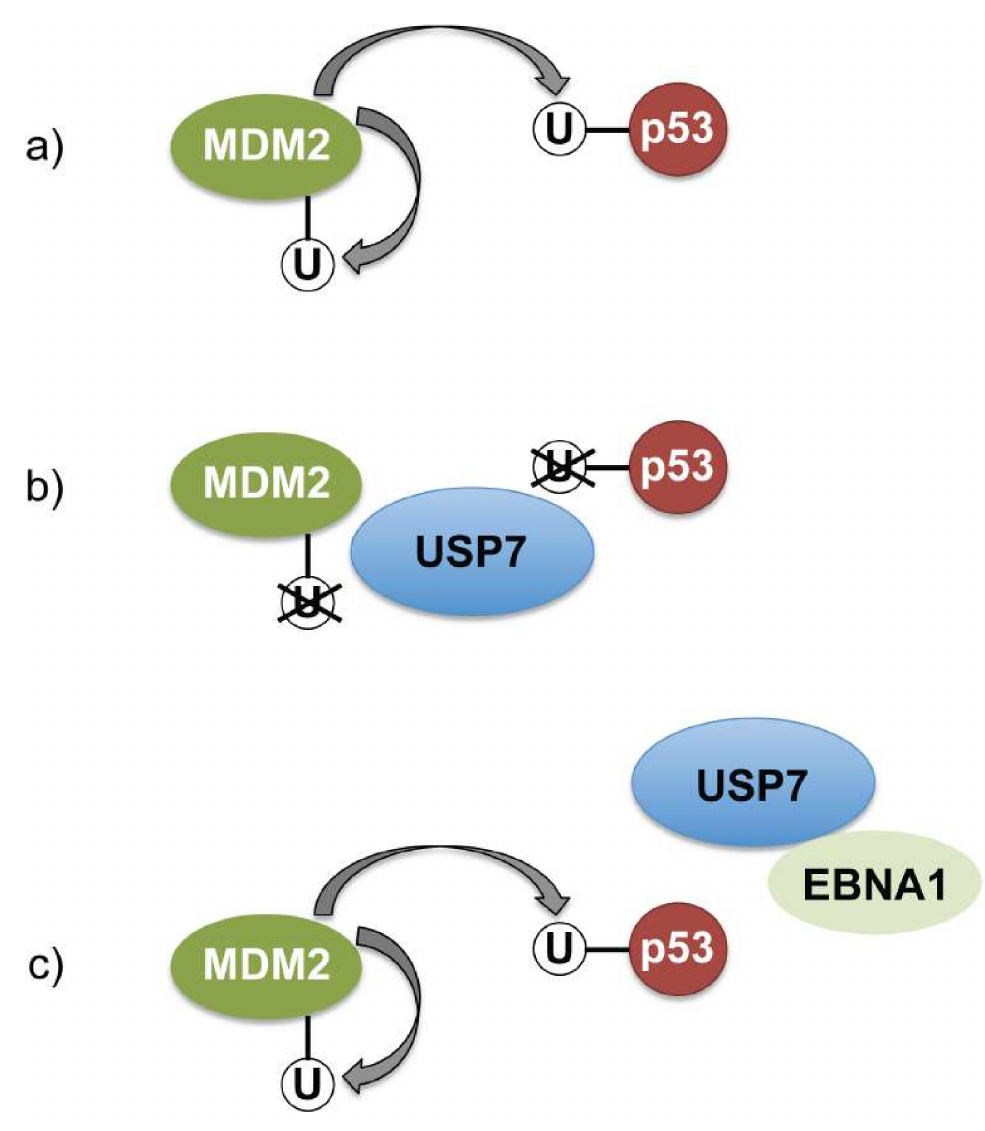
Figure 5. ( a ) MDM2 acts to ubiquitinate both p53 and itself, which will lead to the degradation of the proteins, thus maintaining low levels despite continued expression. ( b ) Under conditions of stress, USP7 functions to remove the ubiquitin groups and thus, protein stabilization. ( c ) The interaction between USP7 and cellular or viral factors provides a potential mechanism to regulate de-ubiquitination of MDM and